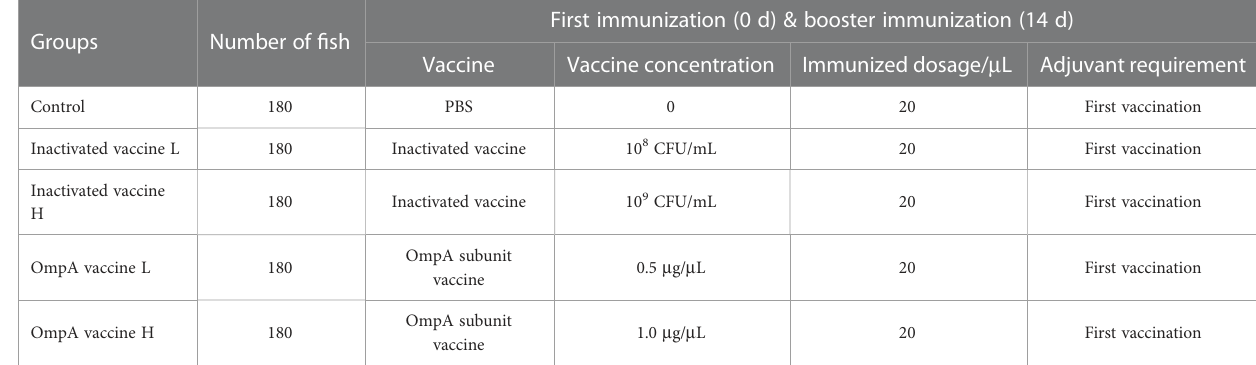
TABLE 1 The immunization procedures and dosages.